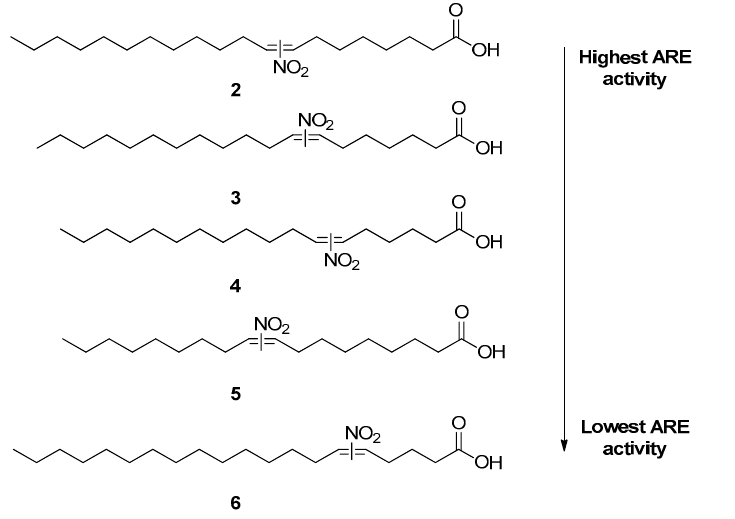
Figure 3. Activation rate of ARE related to different NO 2 -FAs.